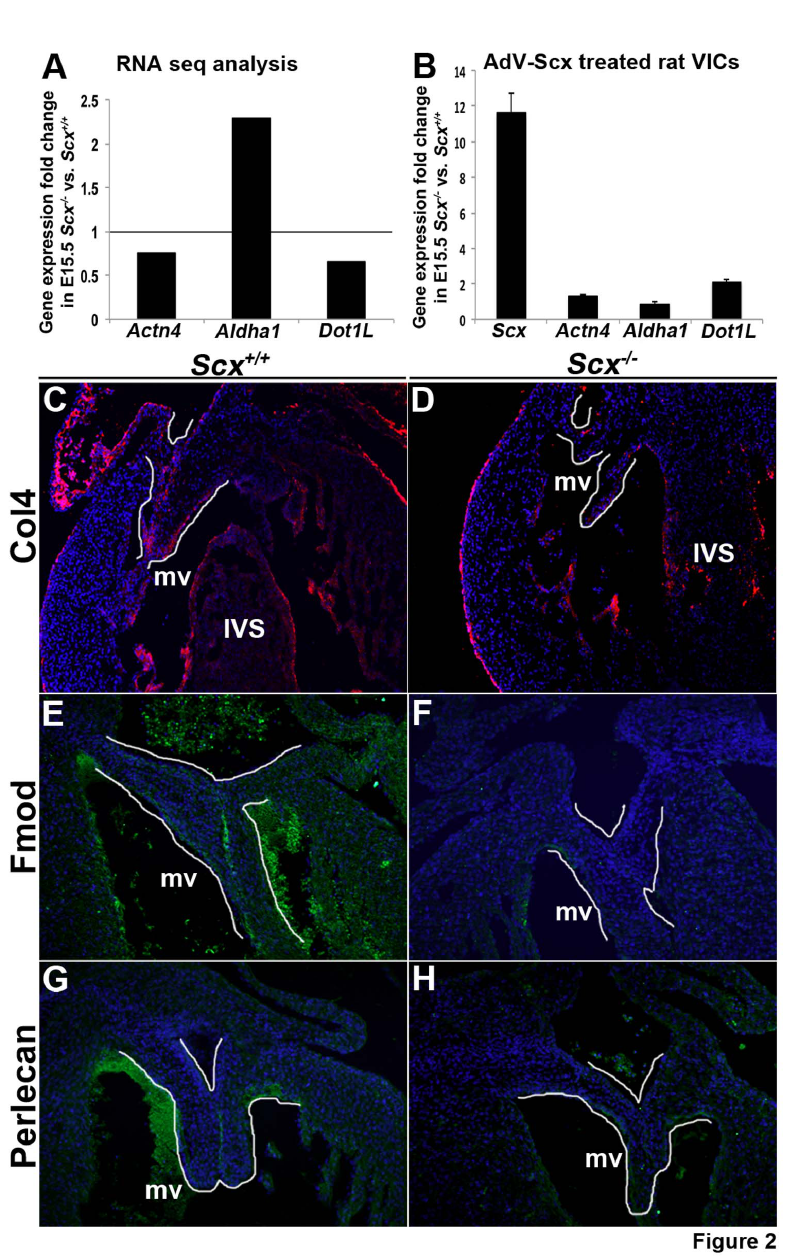
Figure 2. Validation of RNA-seq analysis. (A) Fold changes in gene expression of Actn4, Aldha1 and Dot1L based on RNA-seq analysis. Grey line indicates normalized gene expression levels in Scx + / + controls (set at 1). (B) qPCR to show fold changes in Scx, Actn4, Aldha1 and Dot1L expression in rat VICs infected with an adenovirus overexpressing Scx (AdV-Scx) compared to AdV-GFP infected controls. *, p , 0.05, n=3. Grey line indicates normalized gene expression levels in AdV-GFP treated rat VICs (set at 1). (C-H) Fluorescent immunohistochemistry to detect Type IV Collagen (Col4) (C, D at 10x magnification), Fibromodulin (Fmod) (E, F at 20x magnification) and Heparin sulfate proteoglycan 2 (Hspg2) (G, H at 20x magnification) in mitral valves (highlighted by white line) from E15.5 Scx + / + controls (C, E, G) and Scx -/- (D, F, H) embryos. Note reduced expression in tissue sections from Scx -/- embryos. mv, mitral valve; IVS, interventricular septum.